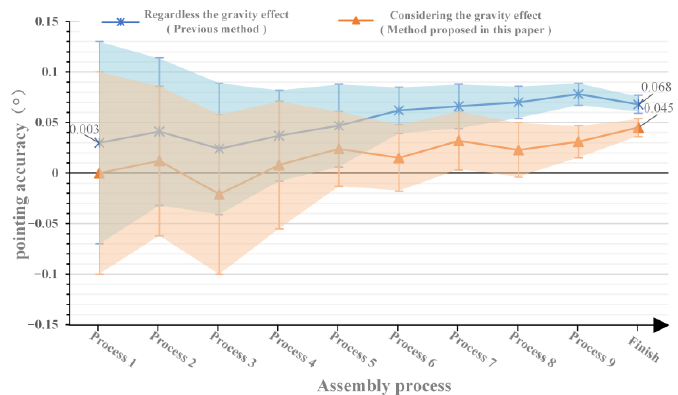
Figure 16. Comparison of pointing accuracy under different assembly methods.